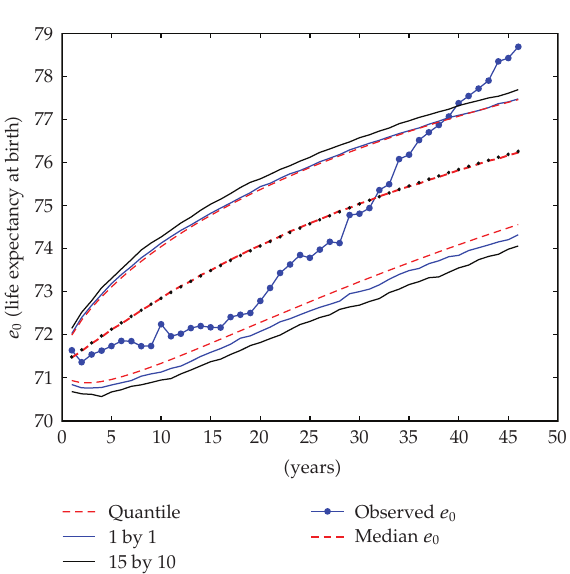
Figure 8: Forecasted e 0 with prediction intervals from di ff erent methods (cid:2) 1921–1960 (cid:3)